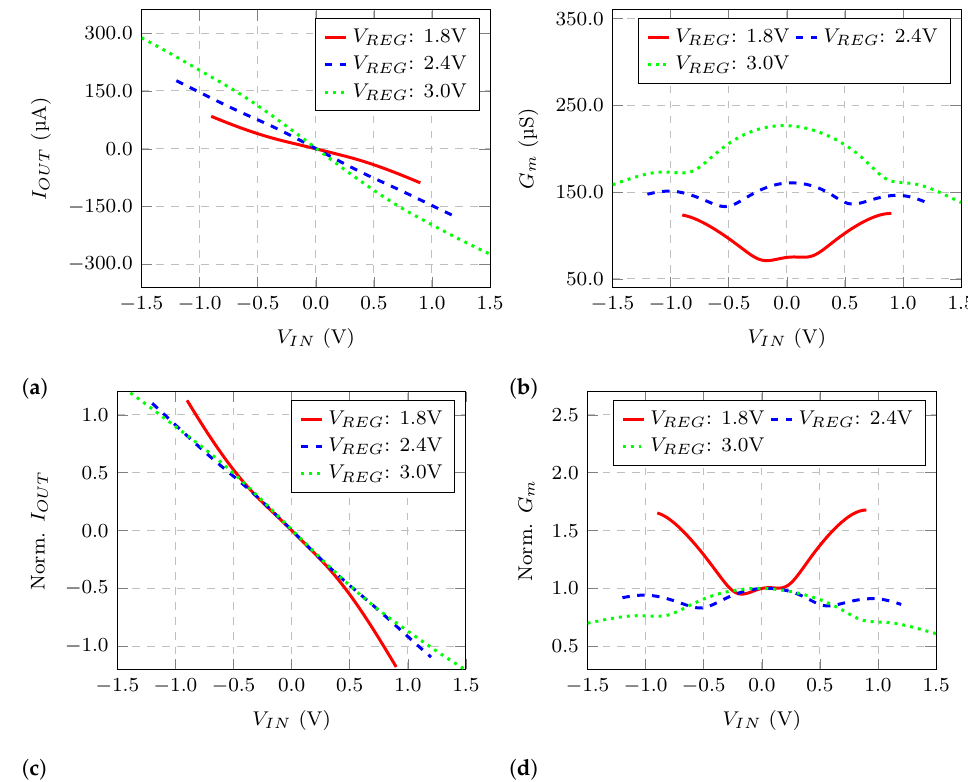
Figure 5. ( a ) Output current × input voltage, ( b ) transconductance × input voltage, ( c ) normalized output current × input voltage, and ( d ) normalized transconductance × input